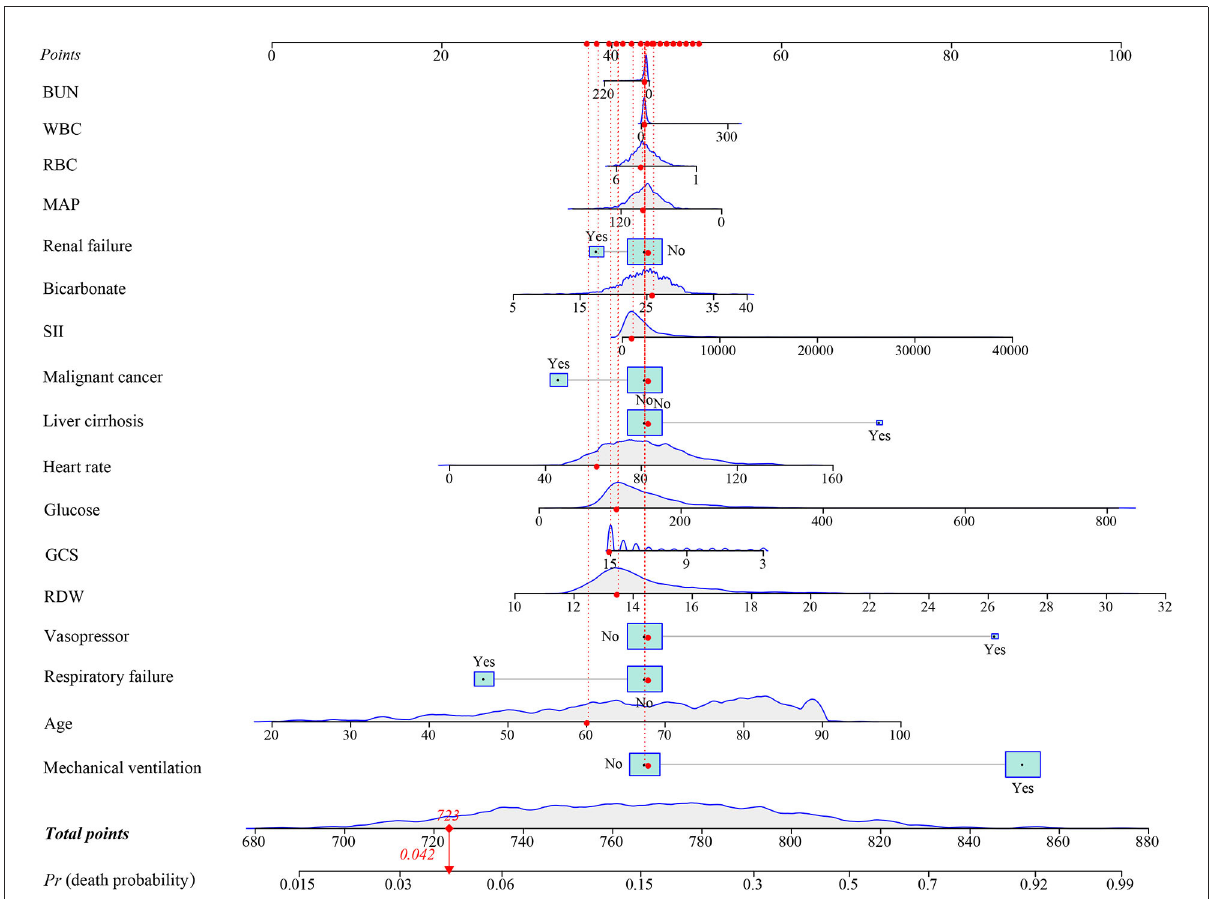
FIGURE4 An example for the application of the nomogram. BUN, blood urea nitrogen; WBC, white blood cell count; RBC, red blood cell; MAP, mean artery pressure; SII, systemic immune-inflammation; GCS, Glasgow Coma Scale; and RDW, red blood cell distribution width.